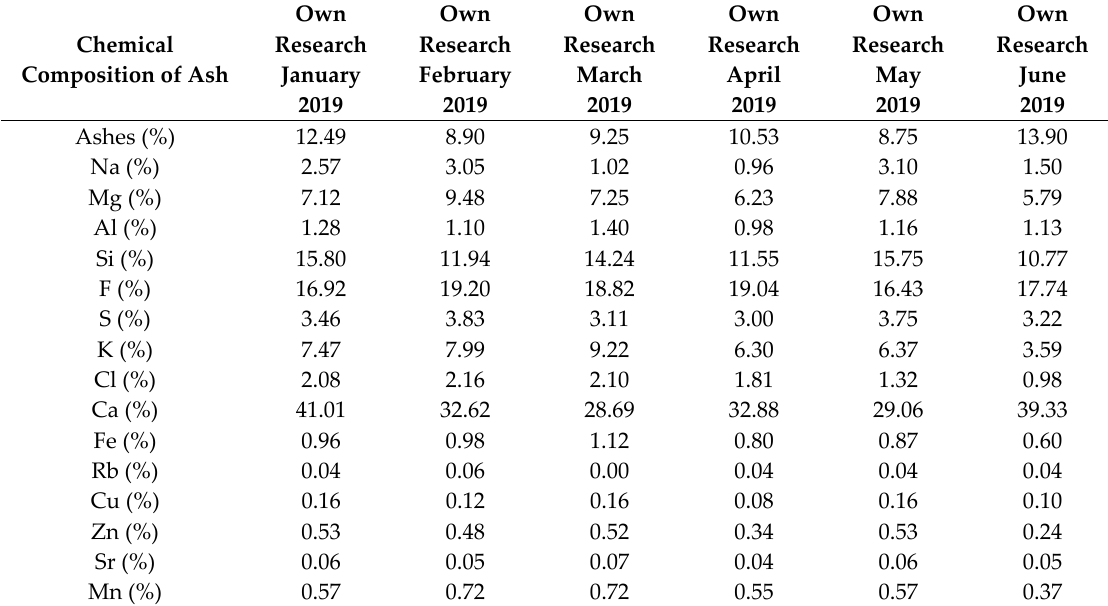
Table 1. Parameters of the chemical composition of ashes from cow dung